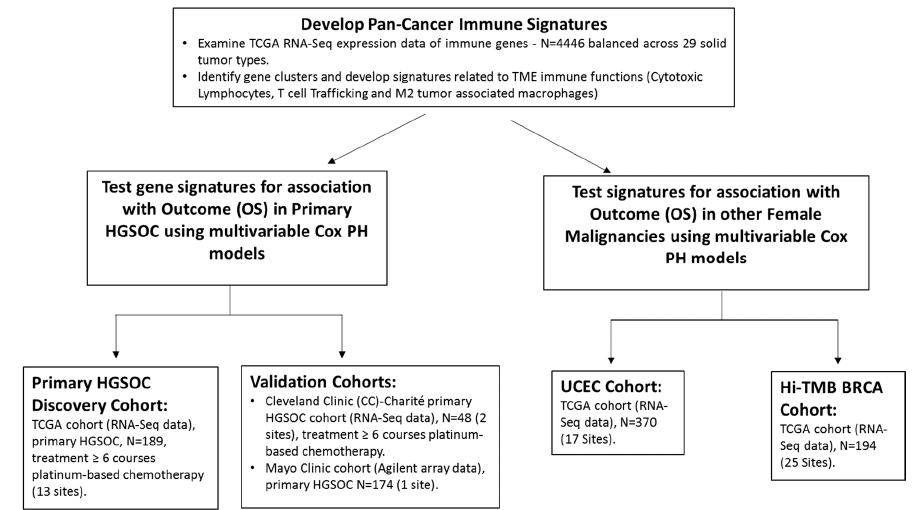
Figure 1. Study design for development of pan cancer immune signature from 29 di ff erent solid tumor types in The Cancer Genome Atlas (TCGA) and testing of the immune signatures for relationship to outcome in HGSOC and other female cancers. Patients in all high-grade serous ovarian cancer (HGSOC) cohorts underwent the cytoreductive surgery of a primary tumor followed by adjuvant platinum-based chemotherapy. OS (overall survival); proportional hazards (PH) UCEC (uterine corpus endometrial cancer); breast cancer (BRCA); tumor mutational burden (TMB); overall survival